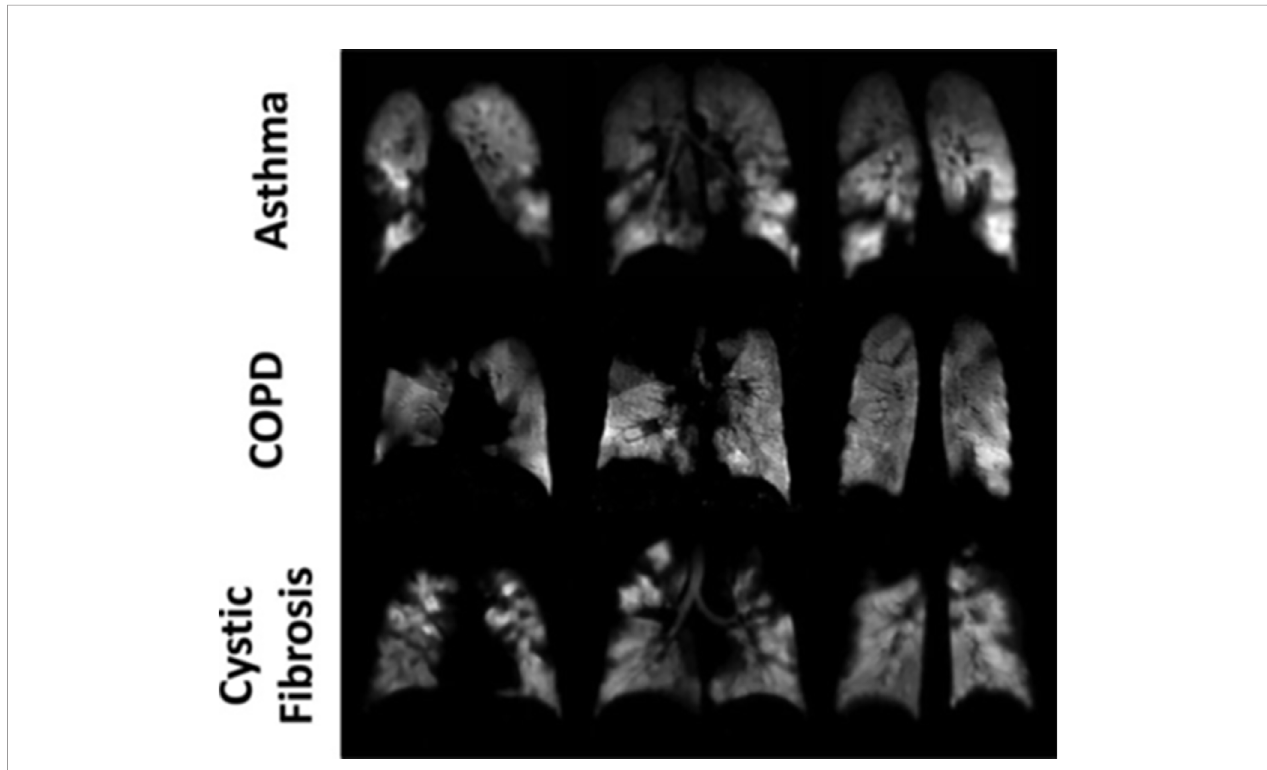
FIGURE 5 | Ventilation imaging of the diseased human lung using 129 Xe-MRI. Coronal ventilation images were acquired in subjects with asthma (upper row), COPD (middle row), or cystic fi brosis (lower row). Numerous ventilation defects can be seen in each of the images secondary to air fl ow obstruction caused by the underlying diseases. Figure taken from Mugler, J. P. et al., Journal of Magnetic Resonance Imaging